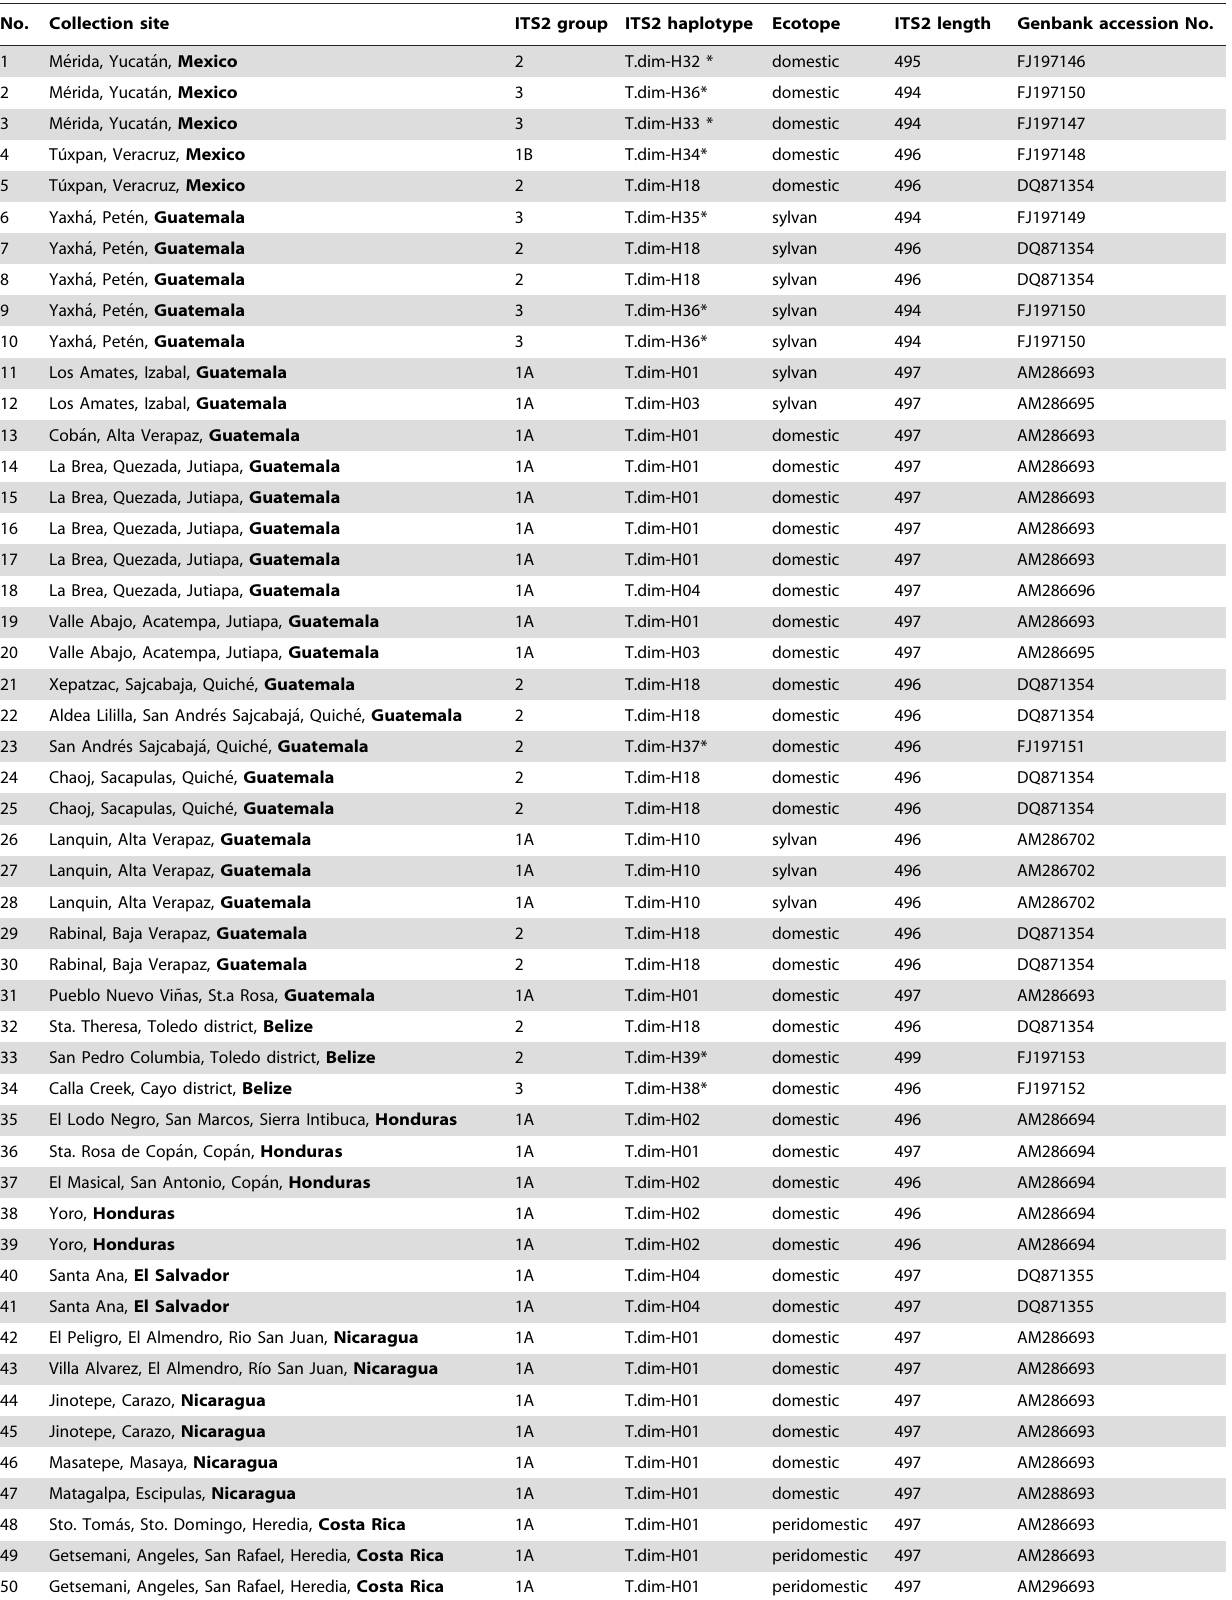
Table 1. T. dimidiata samples studied, including ITS2 group, haplotype, and sequence length in base